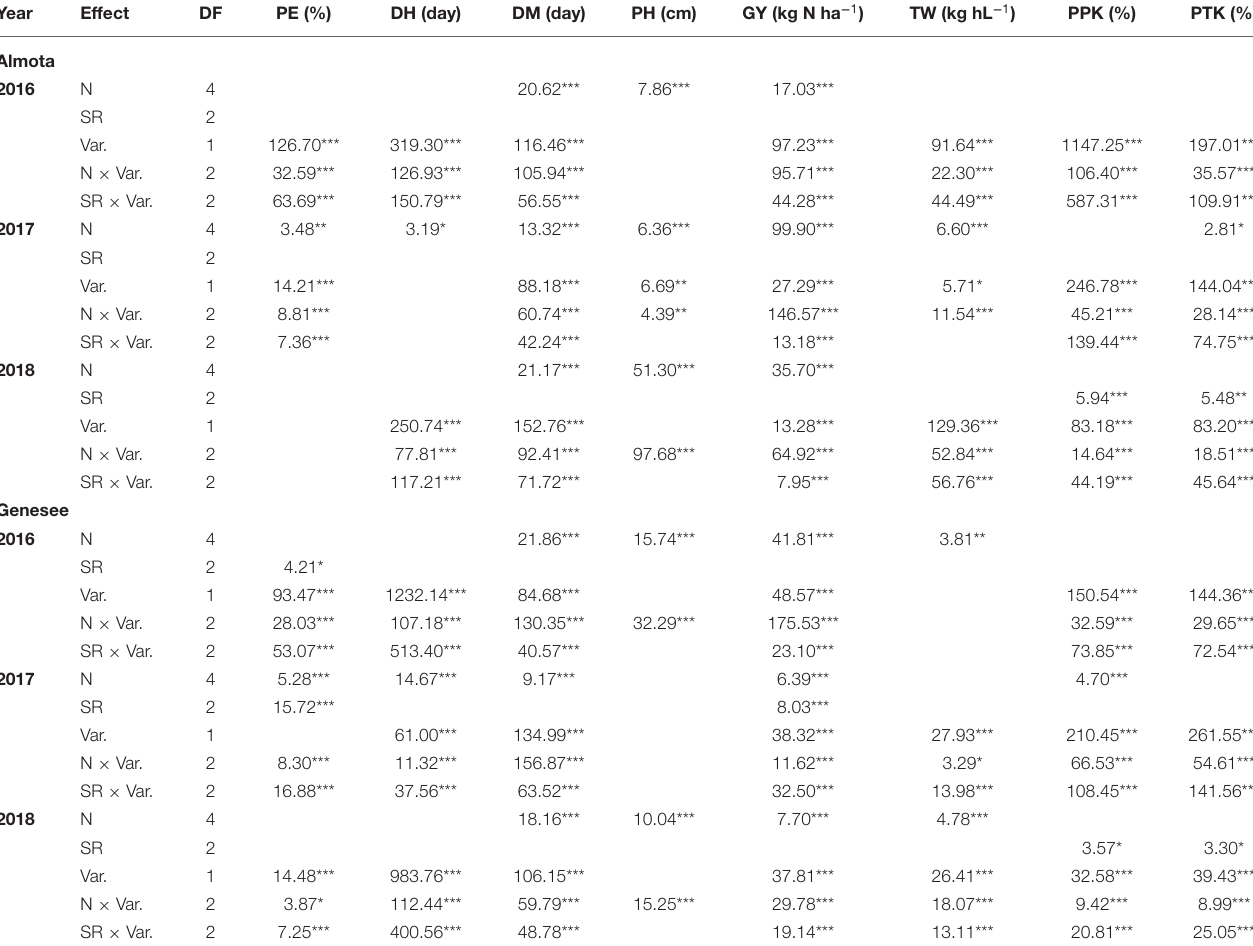
TABLE 4 | Analysis of Variance with F value for emergence rate, day to heading, days to maturity, plant height, grain yield, test weight, percent plump kernels, and percent thin kernels for food barley grown under five nitroge N treatments and three seeding rates on no-till farms of Almota and